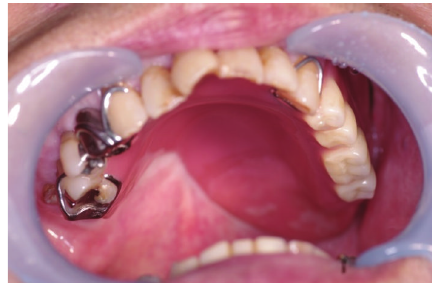
Figure 13: After placement of a denture for a defective maxilla.